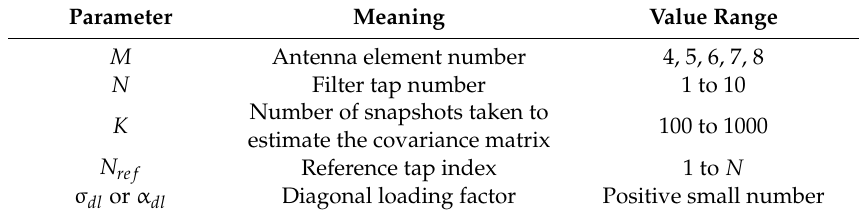
Table 2. Configuration parameters of the Spatial-time adaptive processor (STAP) and their value range. Parameter Meaning Value Range M Antenna element